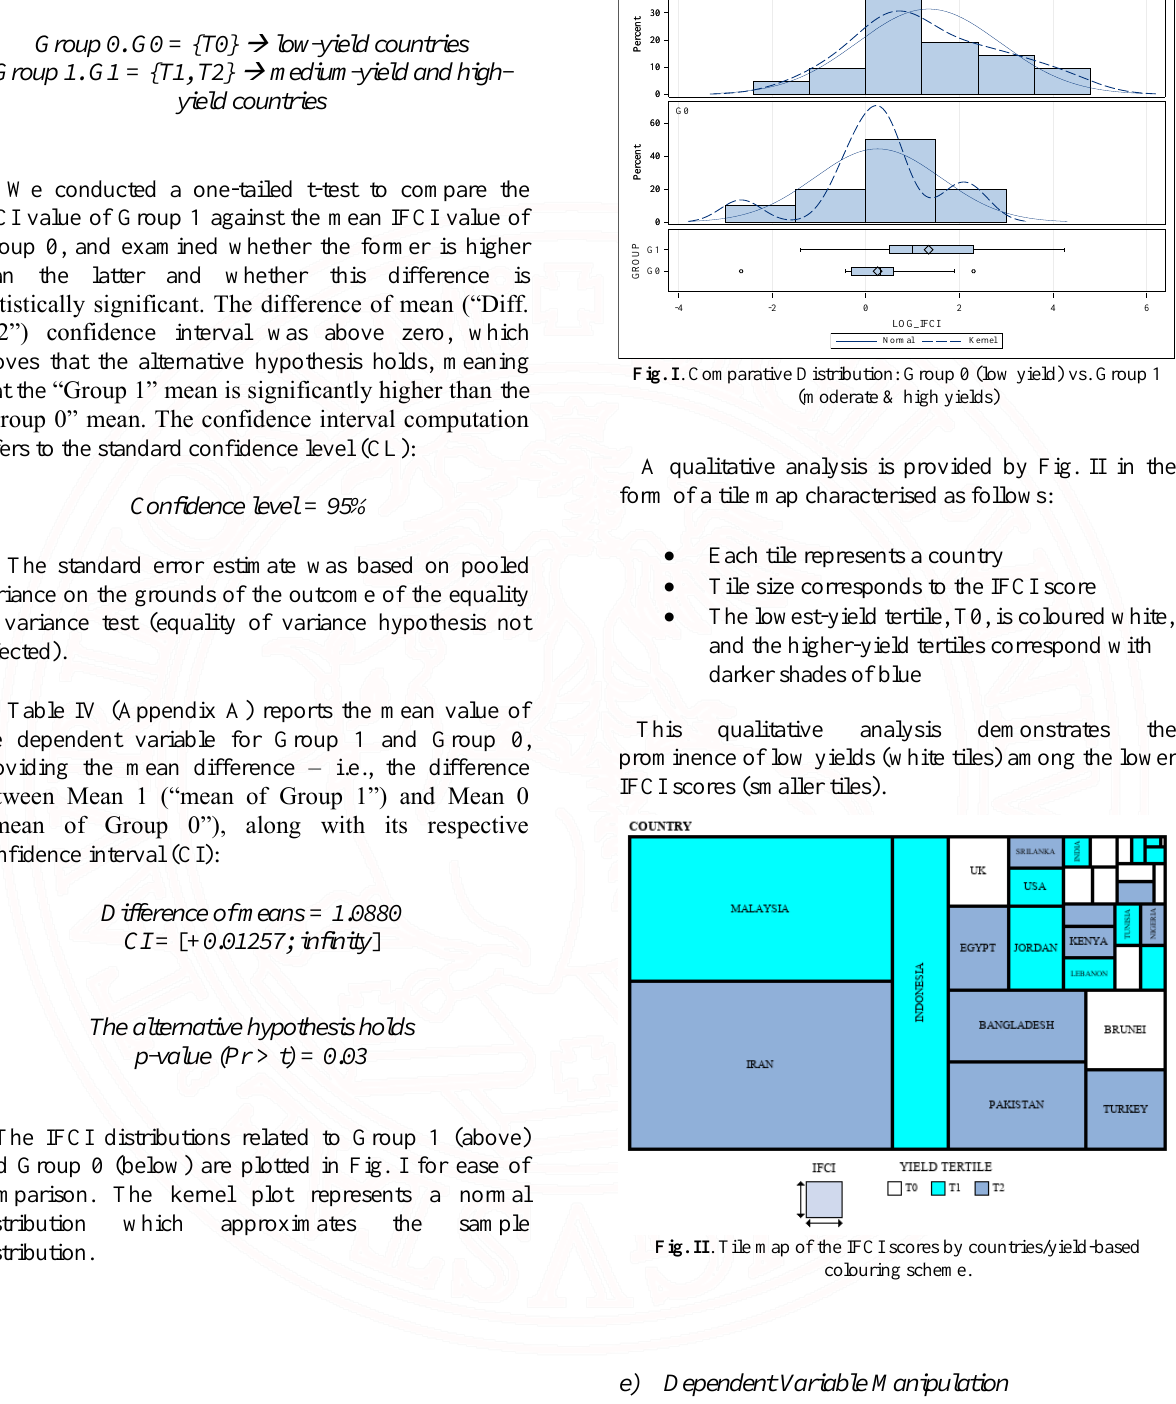
Fig. I . Comparative Distribution: Group 0 (low yield) vs. Group 1 (moderate & high yields)